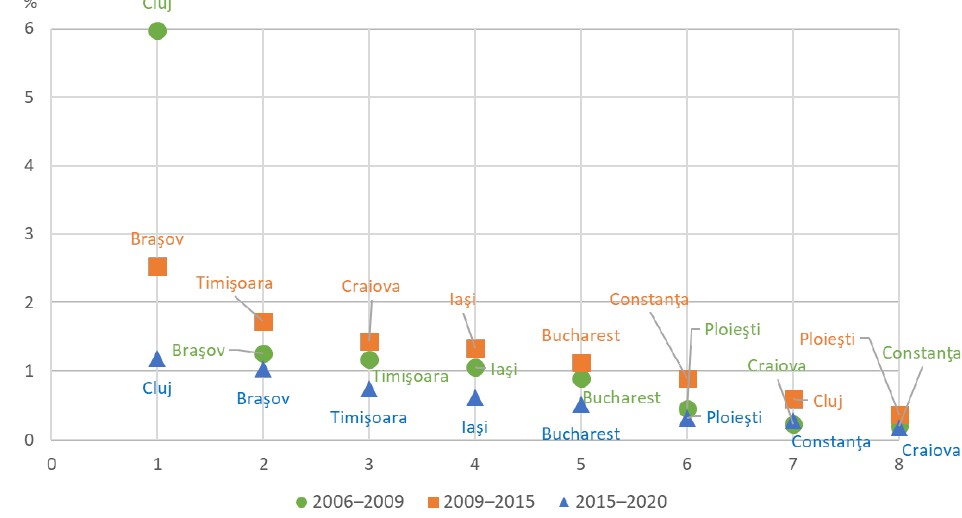
Figure 6. The built-up space average increase rate ranking for the three intervals (Table A1).